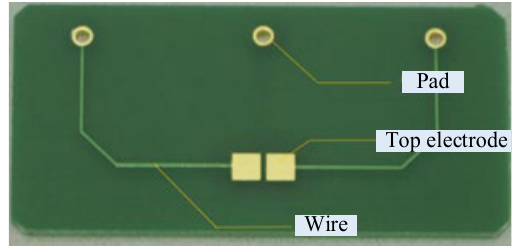
Figure 7. Electrodes on a PCB.